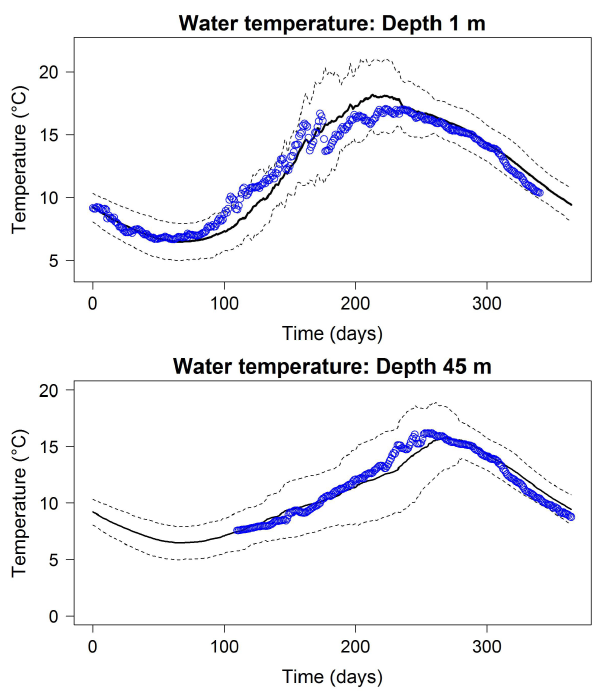
Fig. 4. Water temperatures at depths of 1m and 45m for the year 2007. The mean of 16 ensemble runs of the hydrodynamic model (black solid line), the 95% confidence interval of these ensemble runs (black dashed line). The observational data from by the CEFAS buoy (blue points) are